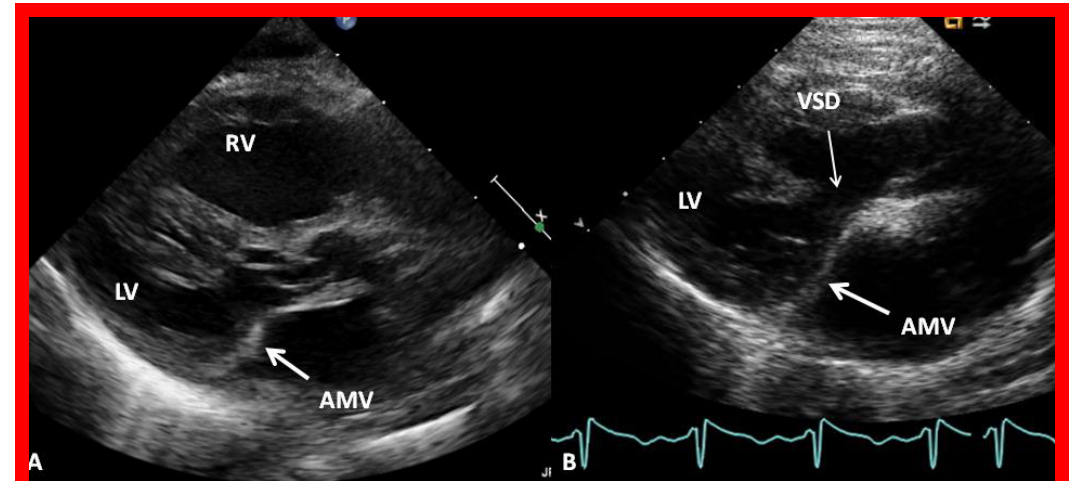
Figure 1. Selected video images from modified apical four-chamber views of two babies with mitral atresia illustrating atretic mitral valves (AMV), shown by thick arrows. The left atrium (LA) and left ventricle (LV) are small while and the right ventricle (RV) is large ( A ). A restrictive patent foramen ovale (PFO) is shown by a thin arrow in ( B ). Reproduced from [7].